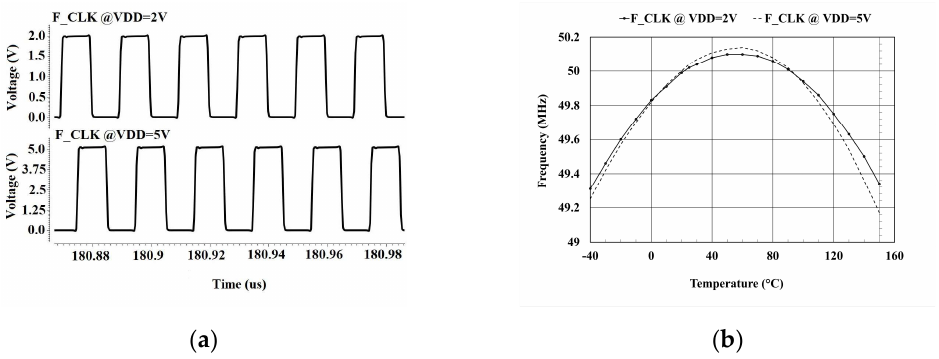
Figure 7. Typical simulation results for the clock circuit. ( a ) Time response; ( b ) Frequency variation with temperature and VDD.